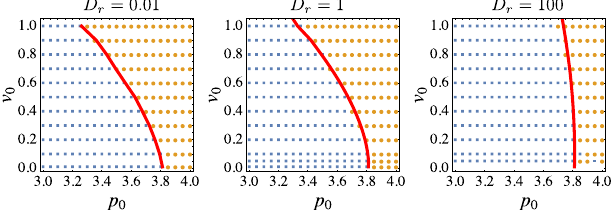
7. Comparison between glass transition boundaries ob- tained using shape order parameter (red line) and D squares and orange